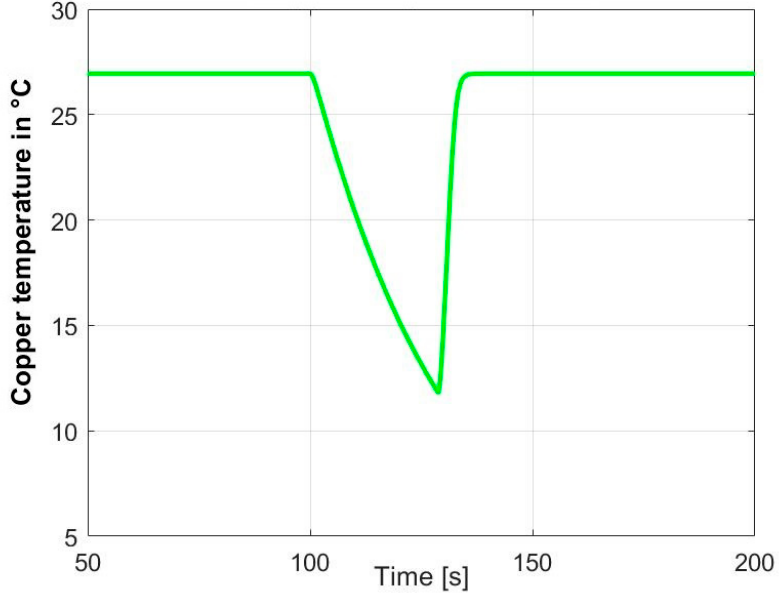
Figure 19. Diagram of copper temperature in function of time for a number of sections n = 20.